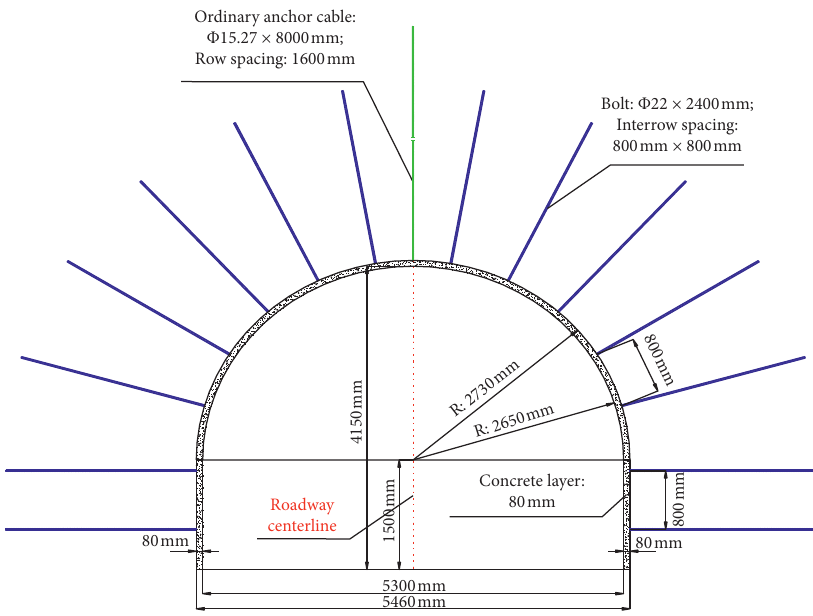
Figure 3: Original support design